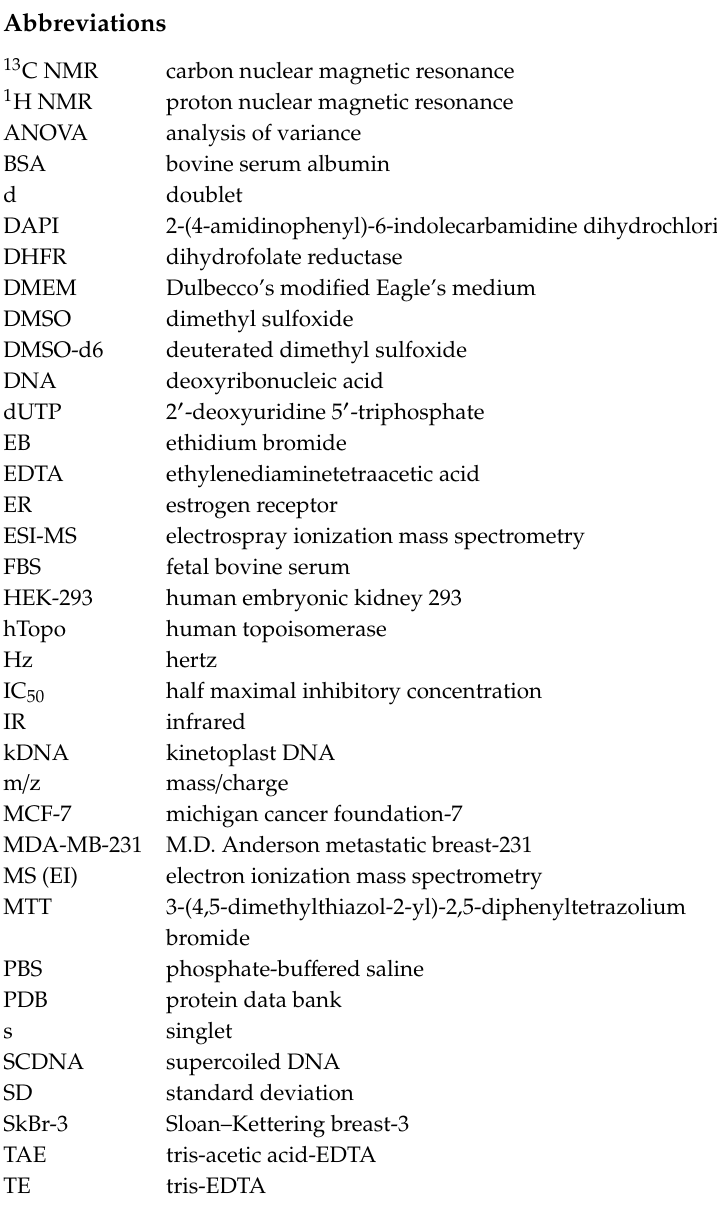
Figure S1: Evaluation of the antiproliferative response to compound 3